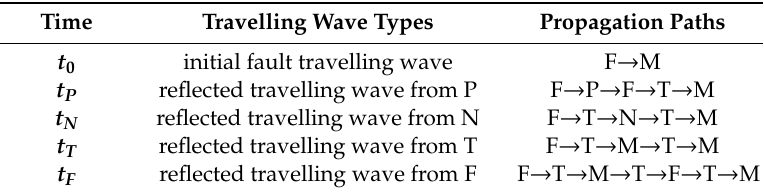
Table 5. Travelling wave types with their reach times.